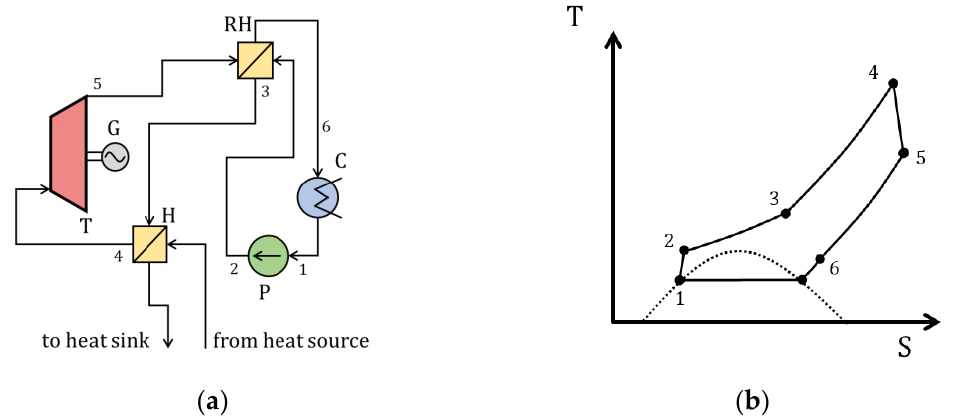
Figure 9. Rankine cycle with regeneration: ( a ) schematic diagram; ( b ) T – S diagram [19]. H — heater;